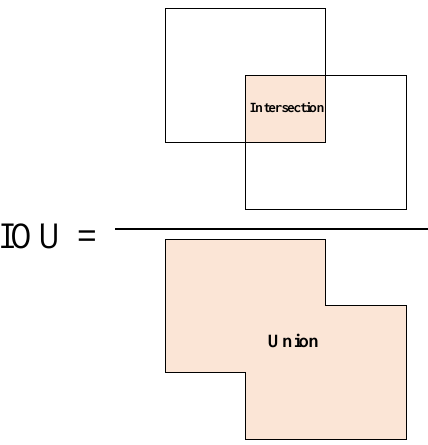
Figure 7. The definition of Intersection over Union (IOU).